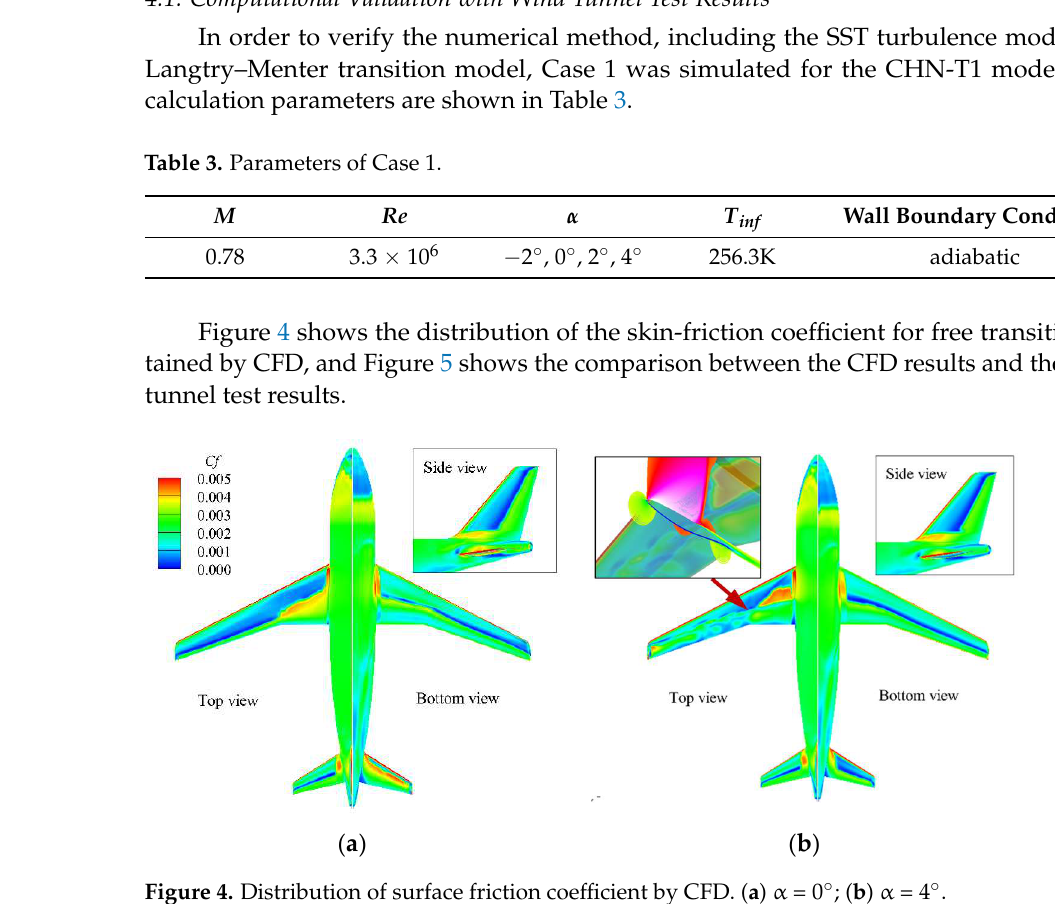
( b ) Figure 5. Aerodynamic characteristics by CFD and wind tunnel test. ( a ) C L – C D ; ( b ) C m – C L . From Figure 5, the calculated C L and C D are shown to be in good agreement with the test results at a small angle of a(cid:308)ack, and C m has a difference of about 0.042. Usually, the aerodynamic interference of sting support induces a downward pitching moment that re- mains almost unchanged from the angle of a(cid:308)ack before flow separation occurs [19]. Since the pitching static margin (slope of C m vs. C L curve) is the primary interest of the present study, rather than the accurate prediction of the pitching moment intercept ( C m 0 ), the cor- rection was made based on the difference between experimental and computational re- sults. The corrected computational results of C m were obtained by subtracting the differ- ence Δ C m = 0.042 from the original results. The corrected C m agrees well with the test re- sults. There are differences between the calculated results and the test results at α = 4°, and these are more evident when the transition location is not fixed. In Figure 4b, the serious shock/boundary layer interference on the upper surface of the wing can be seen. The near- normal shock on the leeward side of the wing causes a local separation and an abrupt thickening of the boundary layer. Therefore, an abrupt change in C f can be noted. The numerical method that was used in the present study cannot accurately simulate the flow structure of the wind tunnel test. In general, both the full turbulence simulation based on the SST model and the free transition results based on the transition model are in good agreement with the fixed tran- sition and free transition results of the wind tunnel test, respectively. The numerical method and model parameters can accurately predict the flow behavior and transition location of the model. 4.2. Influence of Temperature Gradient on Aerodynamic Characteristics